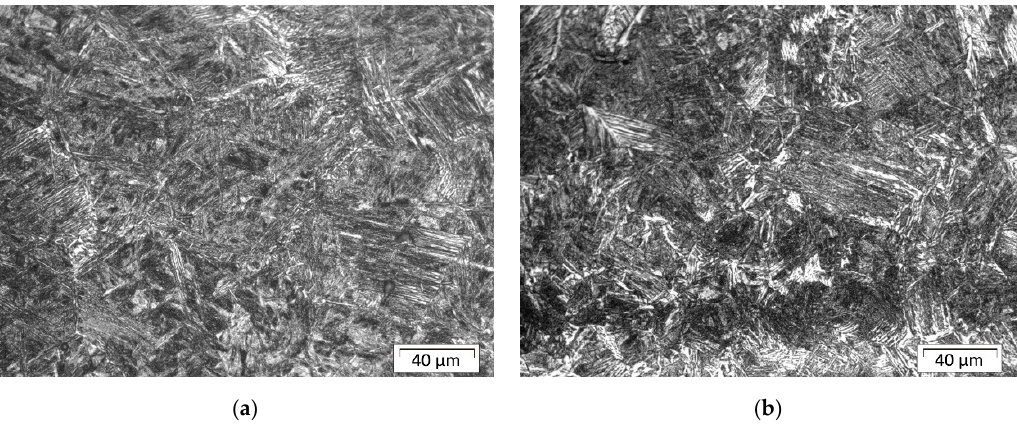
Figure 15. Sample C: ( a ) the structure of the HAZ in front of bead number one; ( b ) the structure of the HAZ close to the fusion line in the axis of bead number one.